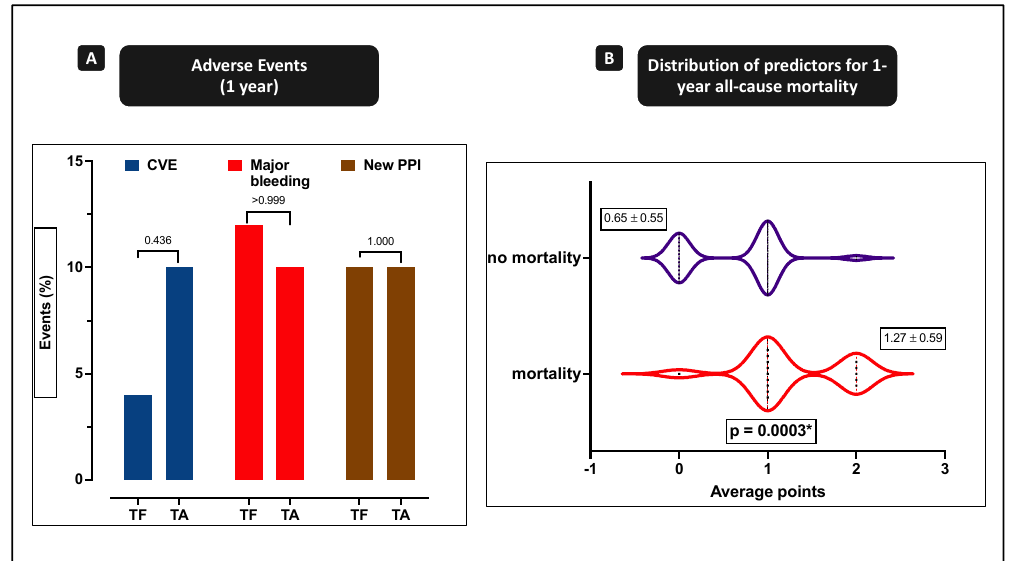
Figure 2. One-year outcome and independent predictors for one-year mortality. ( A ) Cerebrovascular events (CVE), major bleeding, and need for permanent pacemaker implantation (PPI) during one-year follow-up were comparable in both cohorts. ( B ) Distribution of independent predictors for one-year mortality: patients that died from any cause showed a higher summation of the predictors (1.3 ± 0.6 vs. 0.7 ± 0.6; p < 0.001 *). * p < 0.05 Table 4. Univariate and multivariate regression analysis of 1-year mortality. ROC